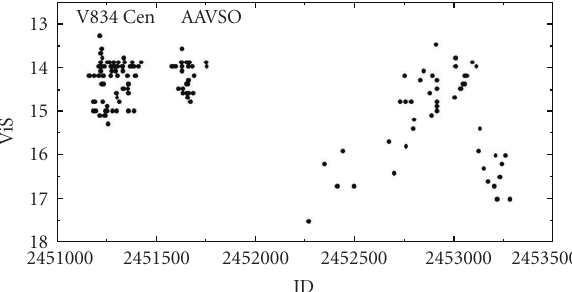
Figure 4: The AAVSO light curve for V834, a cataclysmic gamma- ray loud variable detected by the ESA INTEGRAL satellite. The active state around JD 2453000 represents the time period when the source was detected in gamma-rays, while it remained undetected at times when the source was in the inactive state.